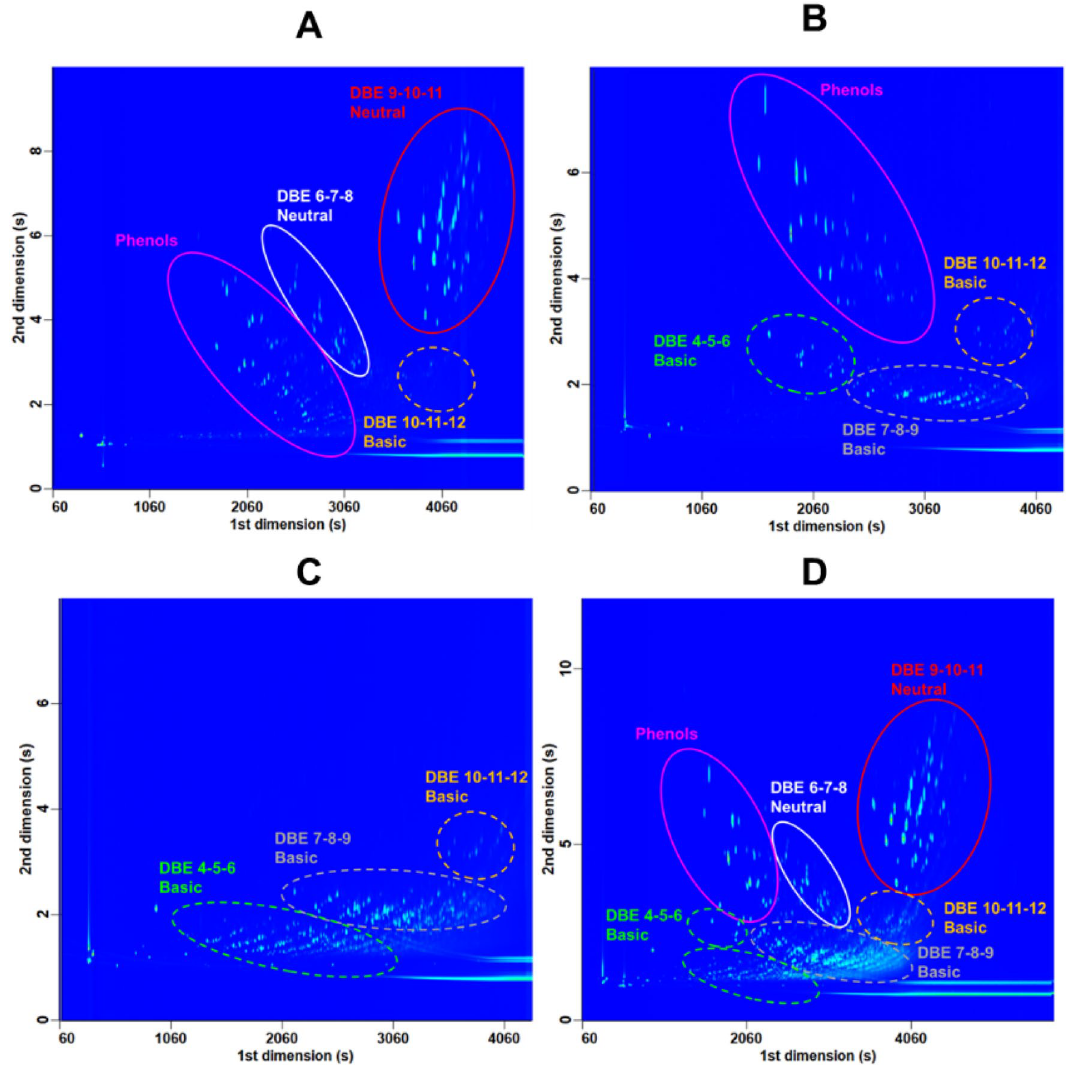
Figure 1. GC × GC/HRMS chromatograms obtained for the fraction F3 ( A ), F4 ( B ), F5 ( C ) and the mixed solution F3F4F5 ( D ) considering the GO 10 sample. The chromatograms were obtained using